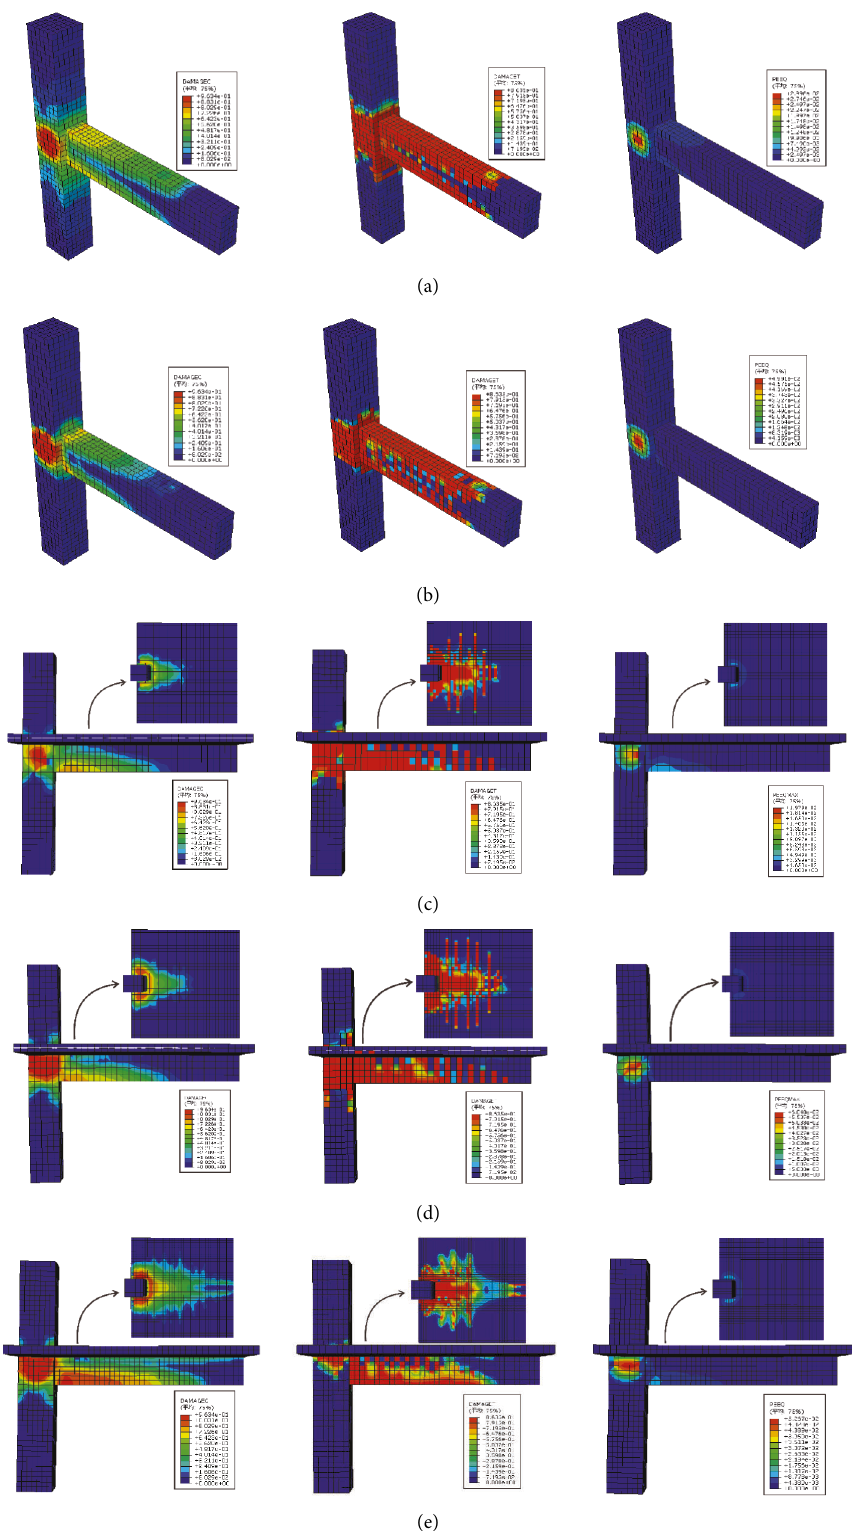
Figure 13: FEA outputs of the exterior beam-column joints at yield force of shear behavior. (a) EBCJ1. (b) EBCJ2. (c) EBCSJ1. (d) EBCSJ2. (e)